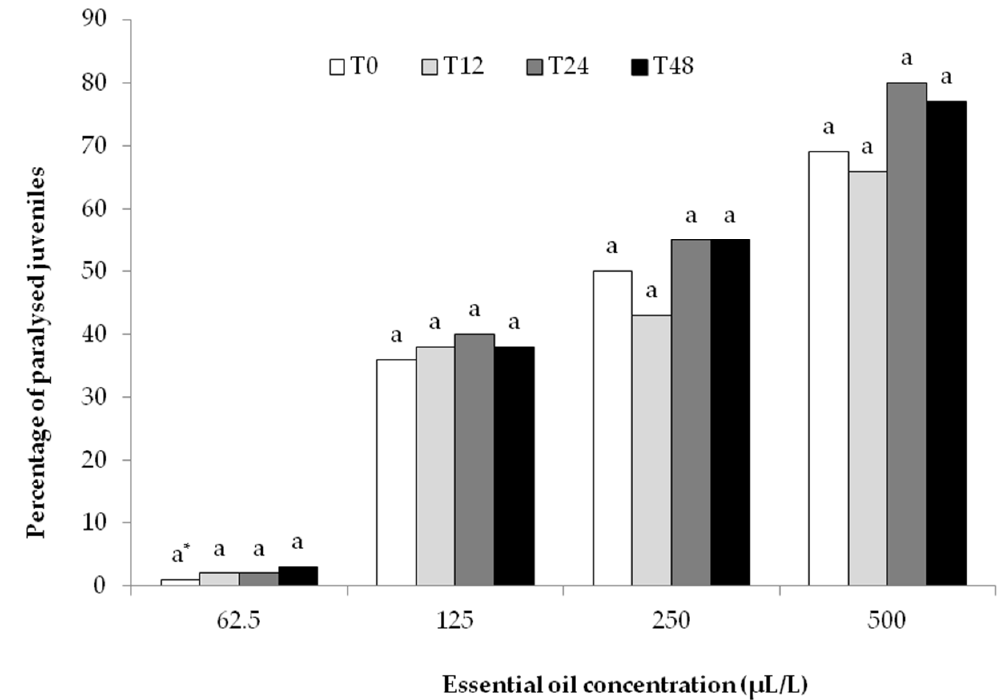
Figure 2. Effect of Cuminum cyminum seed essential oil on the motility of M. javanica J2s after immersion in test solutions at concentrations of 62.5, 125, 250, and 500 µ L/L for 12 h (T0), transferred in water, and counted after 12 (T12), 24 (T24) and 48 (T48) h. * Values for each concentration followed by the same letter are not significantly different according to Tukey’s HSD test at p <